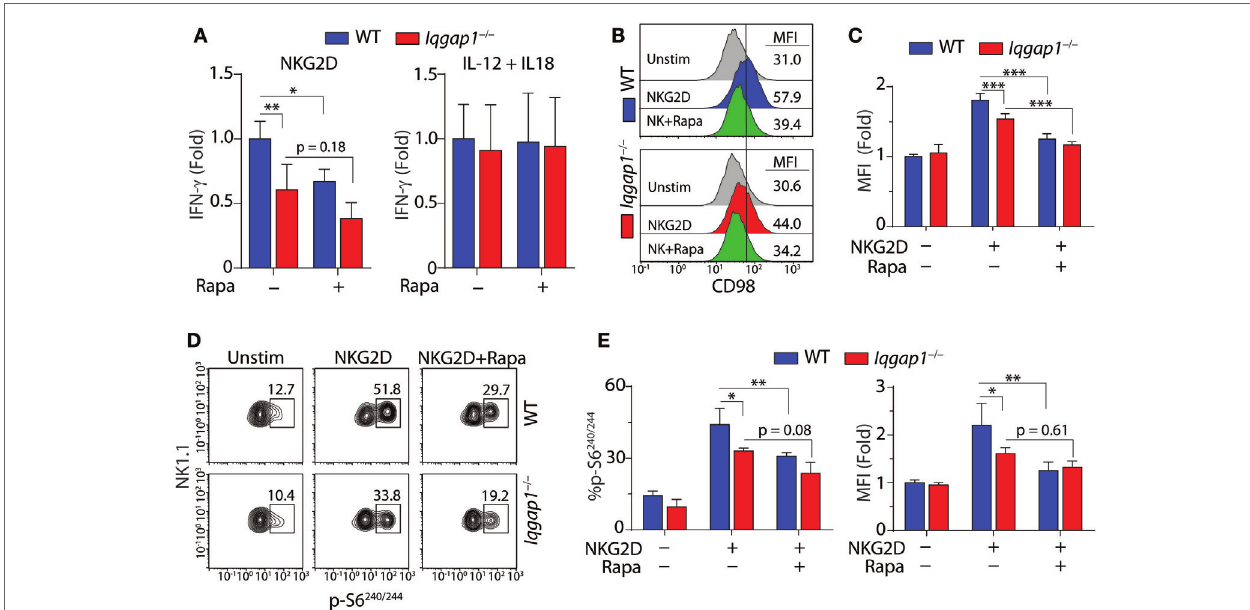
FigUre 7 | Activation of mechanistic target of rapamycin complex 1 (mTORC1) in NKG2D-stimulated natural killer (NK) cells. (a) Fold change in IFN- γ , relative to activated wild-type (WT) NK cells, was evaluated by ELISA in WT and Iqgap1 − / − NK cells 8-h post-NKG2D or IL-12 and IL-18 stimulation with our without the addition of 100 nM rapamycin. (B) Upregulation of CD98 cell surface expression was evaluated by flow cytometry 8-h post-NKG2D activation in WT and Iqgap1 − / − NK cells (CD3 ε − NK1.1 + ). Histograms show representative MFI for each condition and quantified data relative to unstimulated WT NK cells is shown in panel (c) . Rapamycin (100 nM) was added during the 8-h stimulation as a negative control for mTORC1-mediated upregulation of CD98 surface expression. (D) Phosphorylation of S6 at Ser 240/244 in WT and Iqgap1 − / − NK cells was evaluated by intracellular flow cytometry 1-h post-NKG2D stimulation with or without 200 nM rapamycin to illustrate mTORC1-dependent S6 phosphorylation. Shown are representative contour plots with percent positive events within each gate and quantified data represented by percent phospho-S6 positive CD3 ε − NK1.1 + NK cells, as well as fold change in MFI relative to unstimulated WT NK cells, is shown in panel (e) . Error bars represent SD using four mice in two independent experiments, * p < 0.05, ** p < 0.01, and *** p < 0.001 using two-way ANOVA accounting for multiple